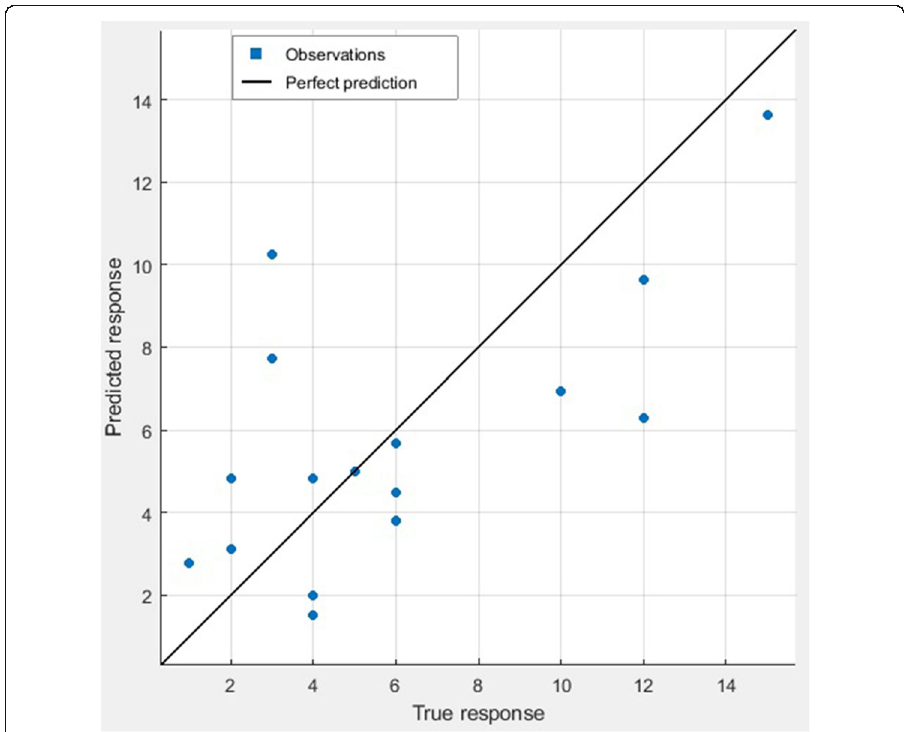
Fig. 3 Actual observations vs. predicted by